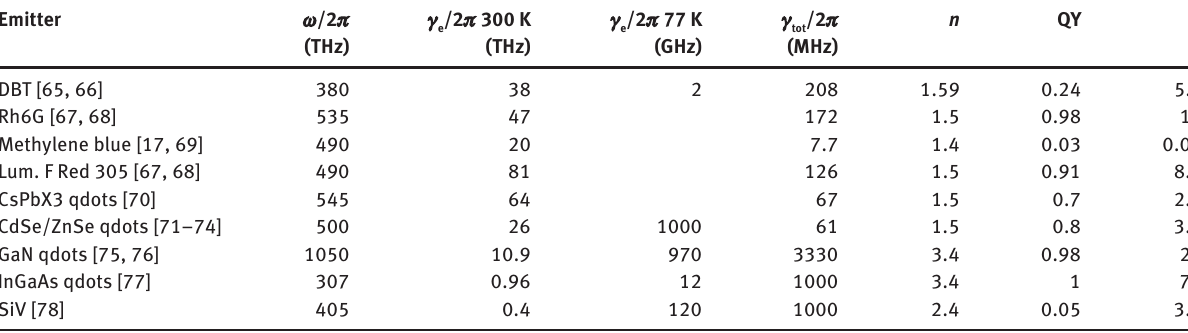
Table 1: Selection of emitters at room and liquid nitrogen temperatures.